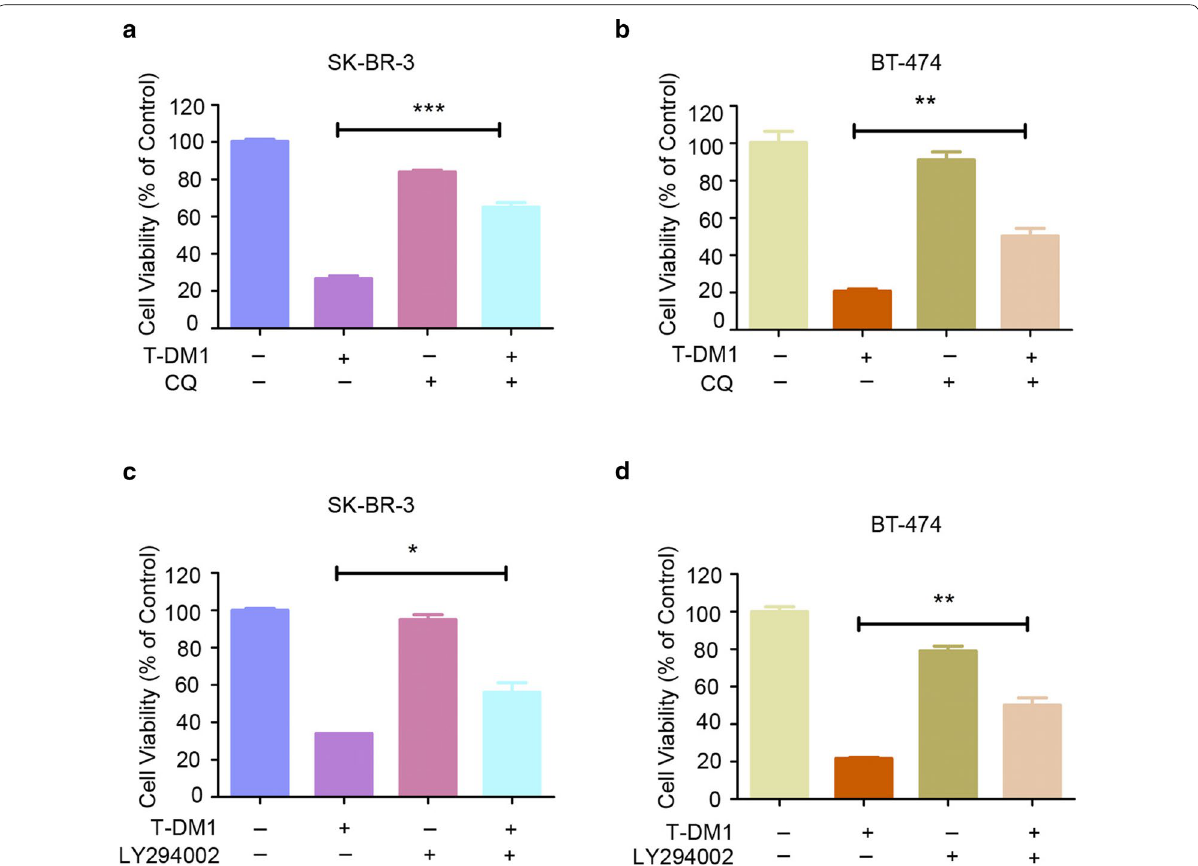
Fig. 3 Autophagy inhibition reversed T-DM1-induced cytotoxicity in both two HER2-positive cells. a , b Before CCK-8 assay, the breast cancer cells were cultured with indicated concentrations of T-DM1 combined with CQ (10 μM) for 3 days. c , d Before cell viability analysis, cells were treated with corresponding concentrations of T-DM1 with or without of 5 μM of LY294002 for 3